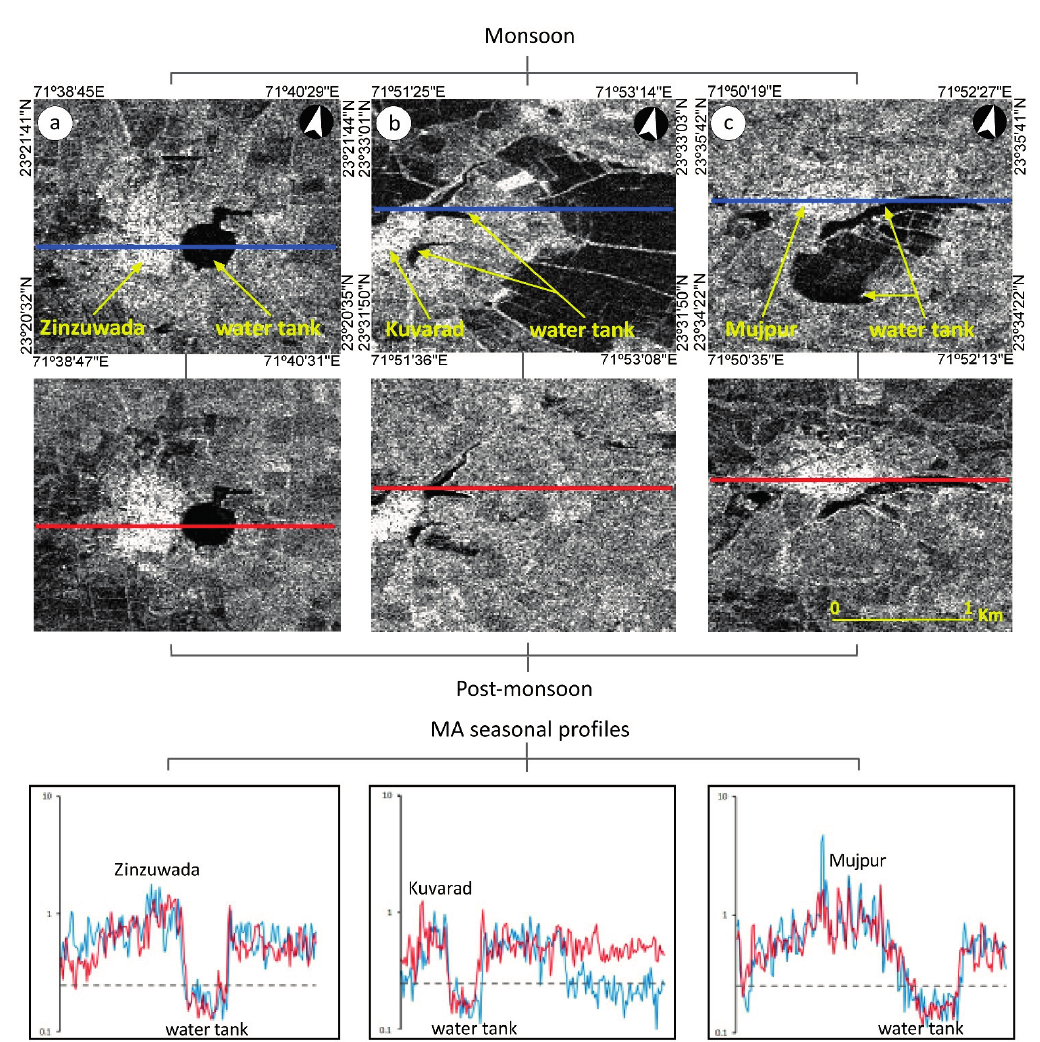
Figure 5. Extraction of water threshold values in equalized MA seasonal images from clearly identified water tanks: ( a ) Zinzuwada village; ( b ) Kuvarad village; ( c ) Mujpur village. Image composition shows, in descending order: MA monsoonal image (horizontal blue line); MA post-monsoonal image (horizontal red line); and MA spatial profile (spatially indicated by the horizontal blue and red lines) for monsoonal and post-monsoonal seasons. The water threshold at 0.25 MA value is indicated as a grey dashed